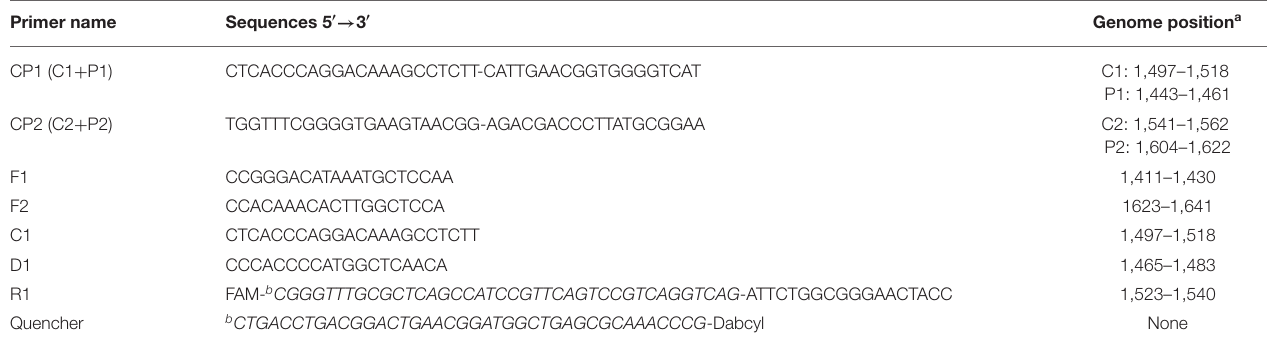
TABLE 1 | Primers of the P-S-MCDA assay for PCV3.